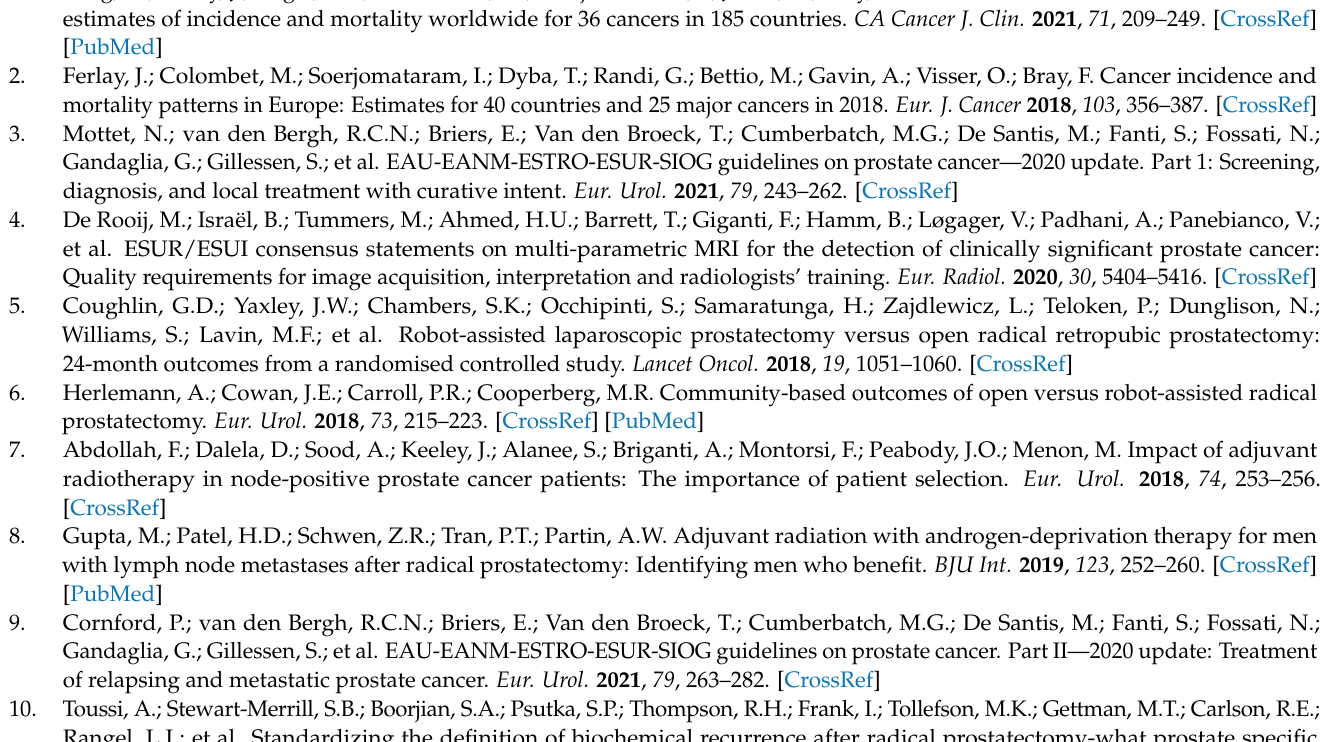
Table S2: Correlation between NIR and sPSA concentrations, Table S3: Univariate BCR-FS outcome, Table S4: Overview of distribution of clinical parameters per defined NIR BCR risk